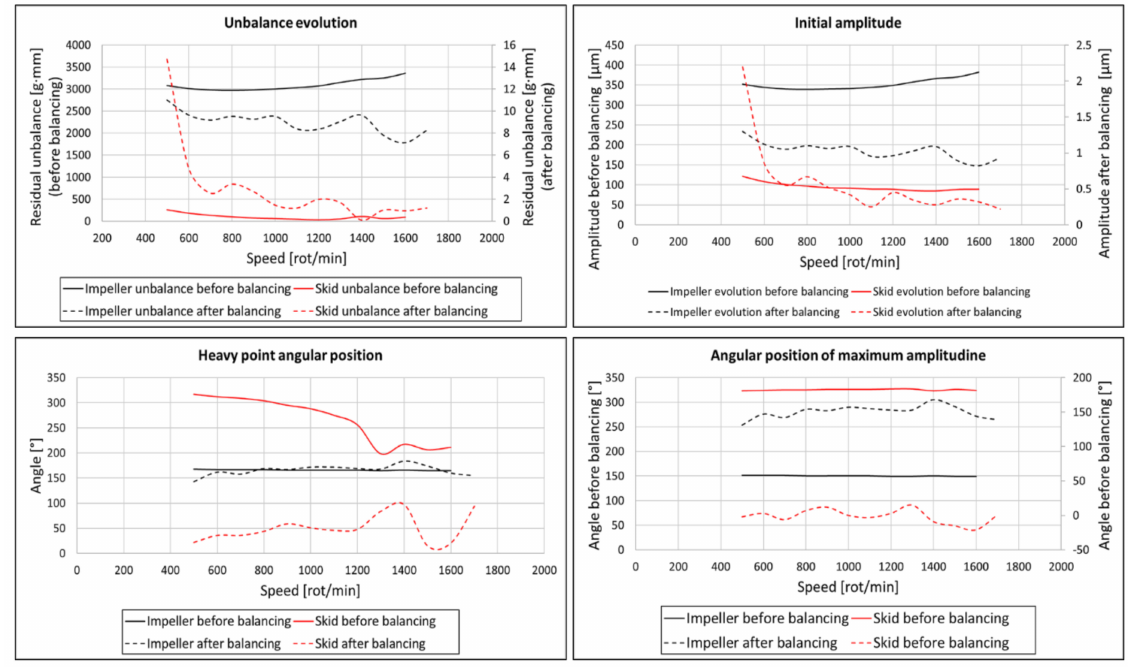
Figure 19. Composite impeller unbalance results before and after balancing